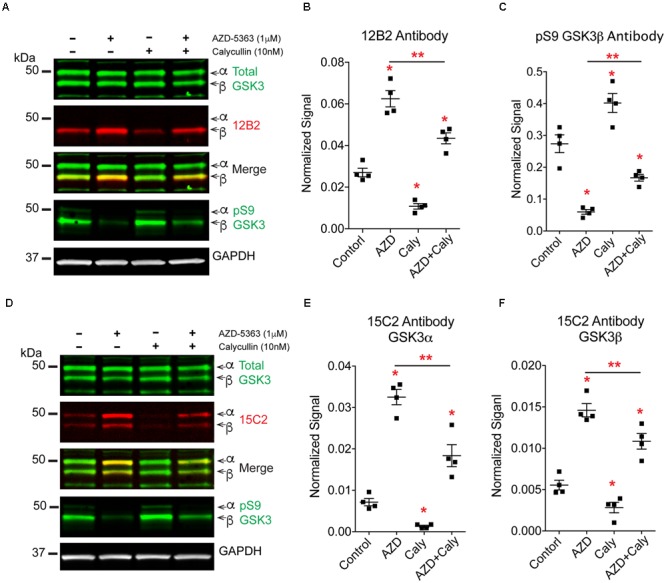
Protein phosphatases regulate GSK3β phosphorylation independent of Akt signaling. HEK293T cells were treated with an Akt inhibitor (AZD-5363, 1 μM), a protein phosphatase inhibitor (calyculin A, 10 nM) or the Akt inhibitor followed by the phosphatase inhibitor. Four independent experiments were run. (A) Western blots of samples were probed with 12B2 (npS9-GSK3β specific), total GSK3α/β, pS9-GSK3β and GAPDH (loading control). (B) Quantitation of the blots shows that inhibition of Akt (AZD) significantly increased npS9 GSK3β, while inhibition of protein phosphatases (Caly) significantly reduced npS9 GSK3β. When Akt signaling was blocked first and then the phosphatase inhibitor was applied (AZD + Caly) a significant reduction in the level of npS9 GSK3β occurred when compared to Akt inhibitor alone. (C) Quantitation of the pS9 GSK3β blots shows an opposite pattern where inhibition of Akt significantly decreased pS9 GSK3β, while inhibition of phosphatases significantly increased pS9 GSK3β. When Akt signaling was blocked and then the phosphatase inhibitor was applied a significant increase in the level of pS9 GSK3β occurred when compared to Akt treatment alone. (D) Western blots of samples were probed with 15C2 (npS9-GSK3α/β specific), total GSK3α/β, pS9-GSK3β and GAPDH (loading control). (E,F) Quantitation of the blots shows that inhibition of Akt significantly increased npS9 GSK3α and β, while inhibition of protein phosphatases significantly reduced npS9 GSK3α and β. When Akt signaling was blocked and then the phosphatase inhibitor was applied a significant reduction in the level of npS9 GSK3β and npS21 GSK3α occurred when compared to Akt inhibitor alone. Collectively, these results suggest protein phosphatases dephosphorylate Ser9/21 independent of Akt signaling. All bands are normalized to GAPDH. All groups were statistically significant from the others in (B,C,E,F), but only ∗p < 0.05 vs. control and ∗∗p < 0.05 vs. AZD alone are indicated to simplify the graph and highlight the critical comparisons (one-way ANOVA, Holm-Sidak post hoc test). Total GSK3α/β levels, total Akt and phospho-Akt immunoblots from these experiment are displayed in Supplementary Figure S5.